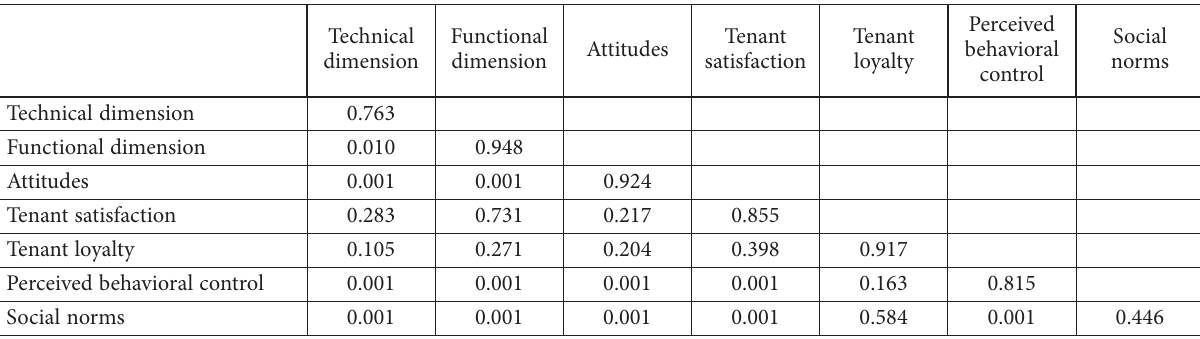
Table 3. Correlation matrix of latent variables